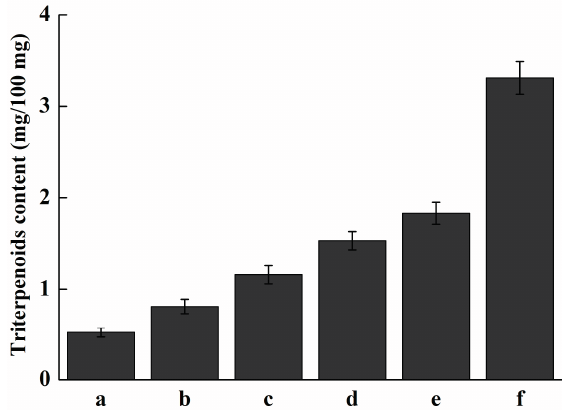
Figure 8. Analysis of the content of total triterpenoids in P. cocos at various developmental stages. (a) 5-day-old mycelium; (b) 10-day-old mycelium; (c) 15-day-old mycelium; (d) 20-day-old mycelium; (e) 30-day-old mycelium; (f)